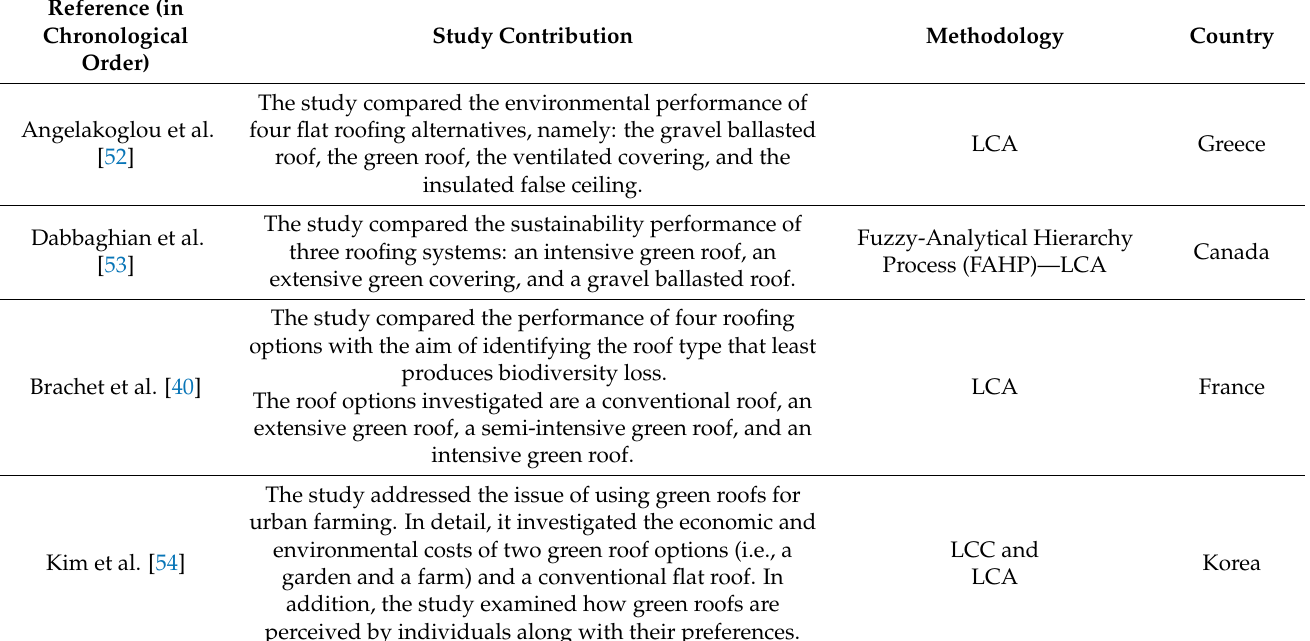
Table 4. General information on the four extra studies dealing with the end-of-life of green roofs identified through the two review